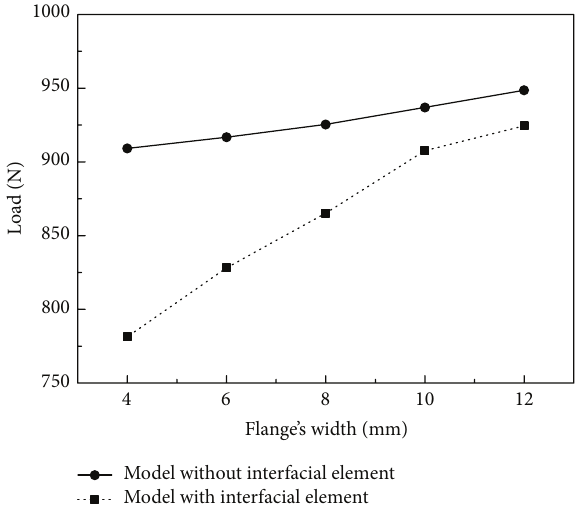
Figure 8: Maximum load versus flange’s width